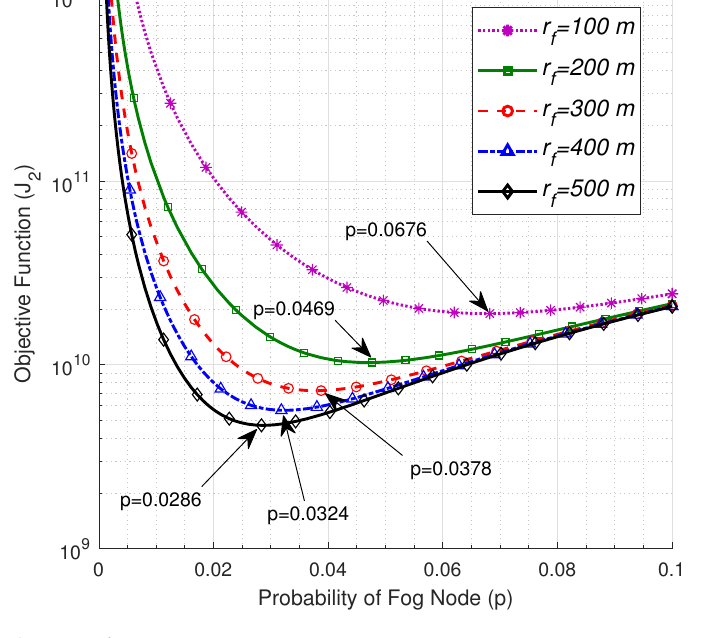
Figure 6. The objective function vs. p at n = 500, α x ( 0 ) = 2, α x ( 1 ) = 4, α y ( 0 ) = 2, α y ( 1 ) = 3, and r c = 500 m .